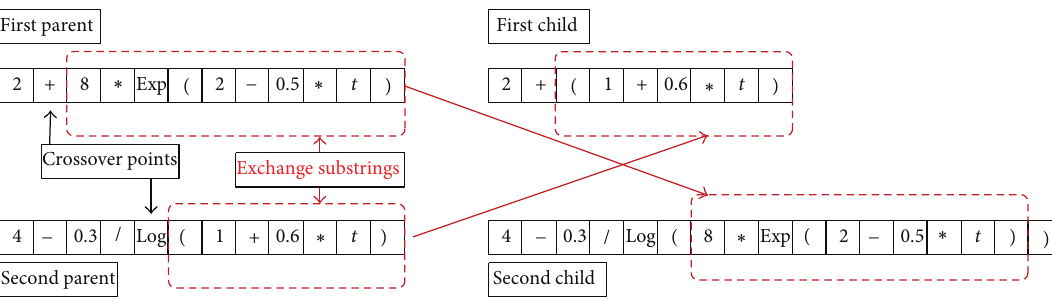
Error (MSE), the Mean Absolute Error (MAE), and the Root Mean Square Error